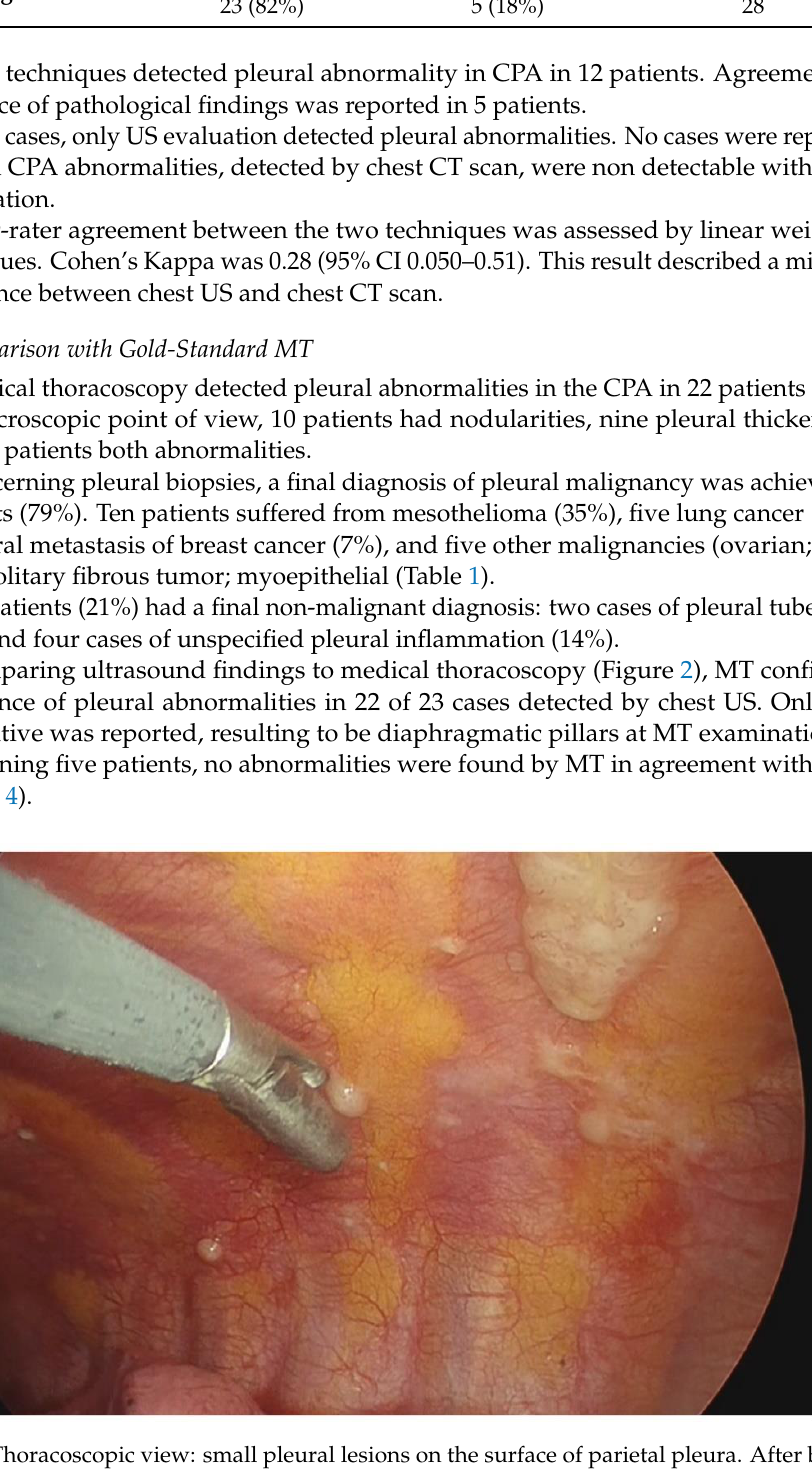
Figure 2. Thoracoscopic view: small pleural lesions on the surface of parietal pleura. After biopsy, pathological examination confirmed a pleural carcinosis from NSCLC. Table 4. Chest US and CT findings compared with MT gold standard.